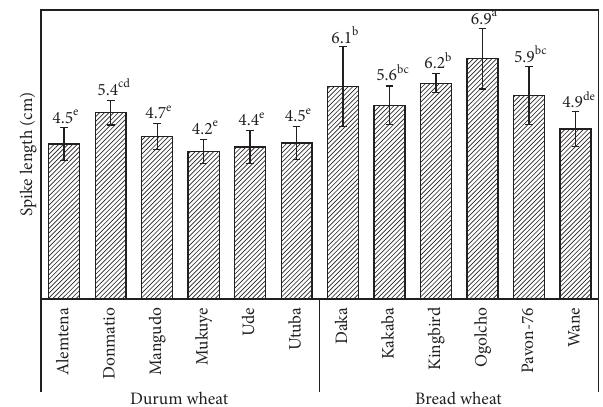
Figure 2: Means for the main effects of variety and water stress on the spike length of durum and bread wheat in Kulumsa.